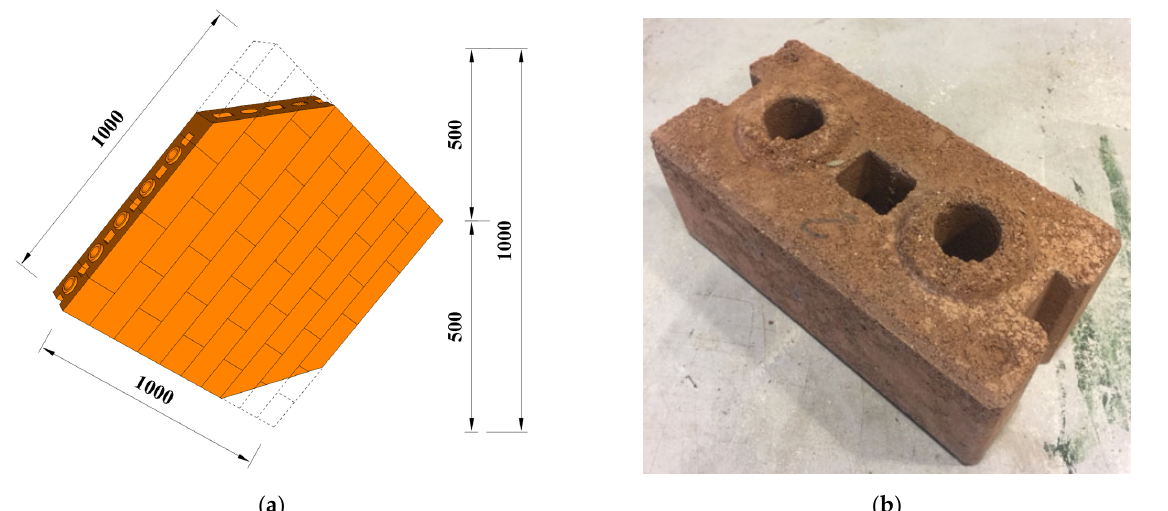
Figure 2. Typical details of the CCI brick masonry wall: ( a ) Wall details (units are in mm); ( b ) CCI brick.